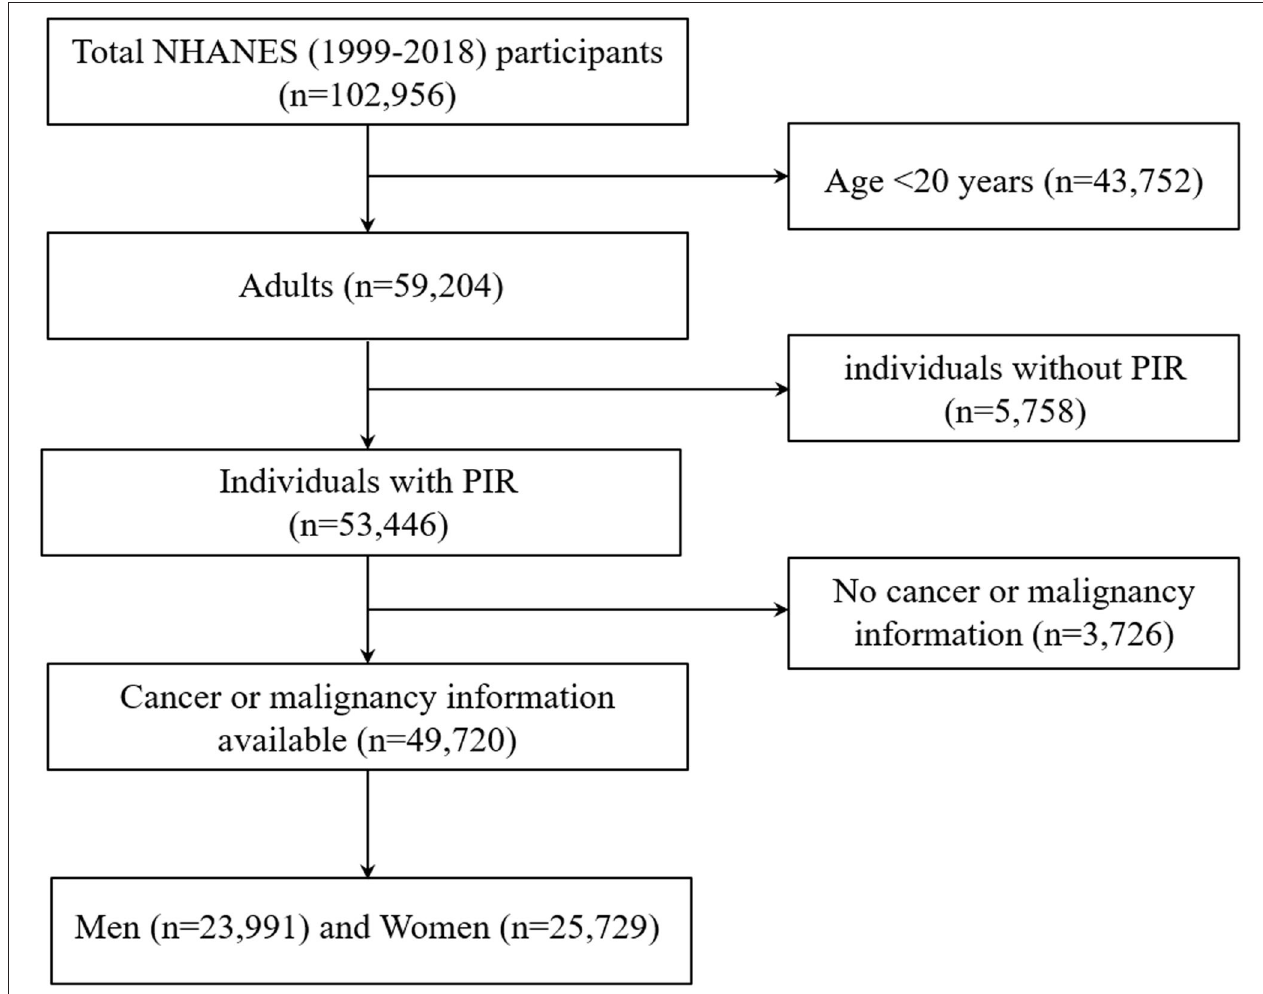
FIGURE 2 | Flow chart of the study population. Describes how the present sample of participants was composed. NHANES, National Health and Nutrition Examination Survey.